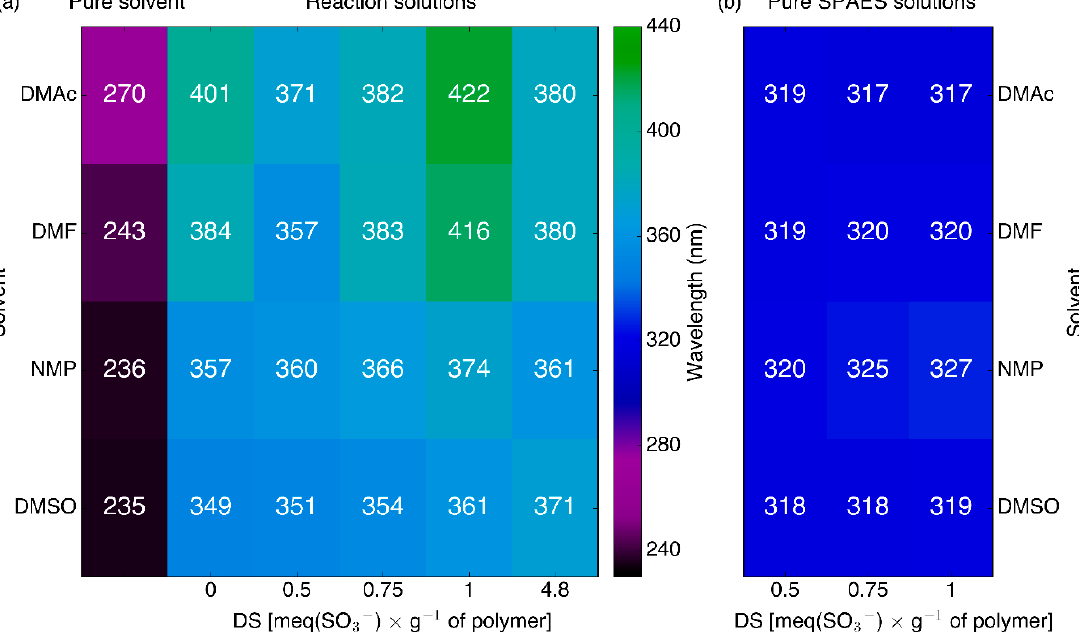
Figure 5. Wavelengths of the absorption maxima of ( a ) pure DMAc, DMF, NMP, and DMSO, and the polymeric solutions of undoped PEDOT, PEDOT_Naph (DS = 4.8), and PEDOT_SPAES (DS = 0.5–0.75–1); and ( b ) pure SPAES dissolved in the same solvents. The same color scale is used in both plots.